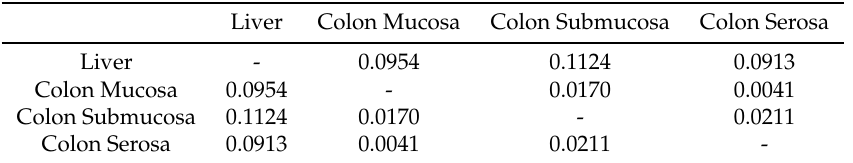
Table 5. Variation (sensibility) of the gain at 700